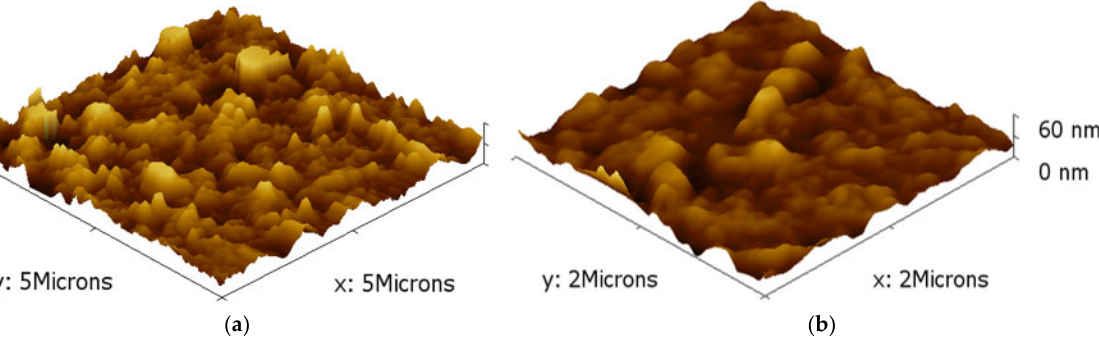
Figure 3. 3 ‐ D AFM micrographs of PAD thin film on quartz glass ( a ) on 5 μ m and ( b ) 2 μ m scale.